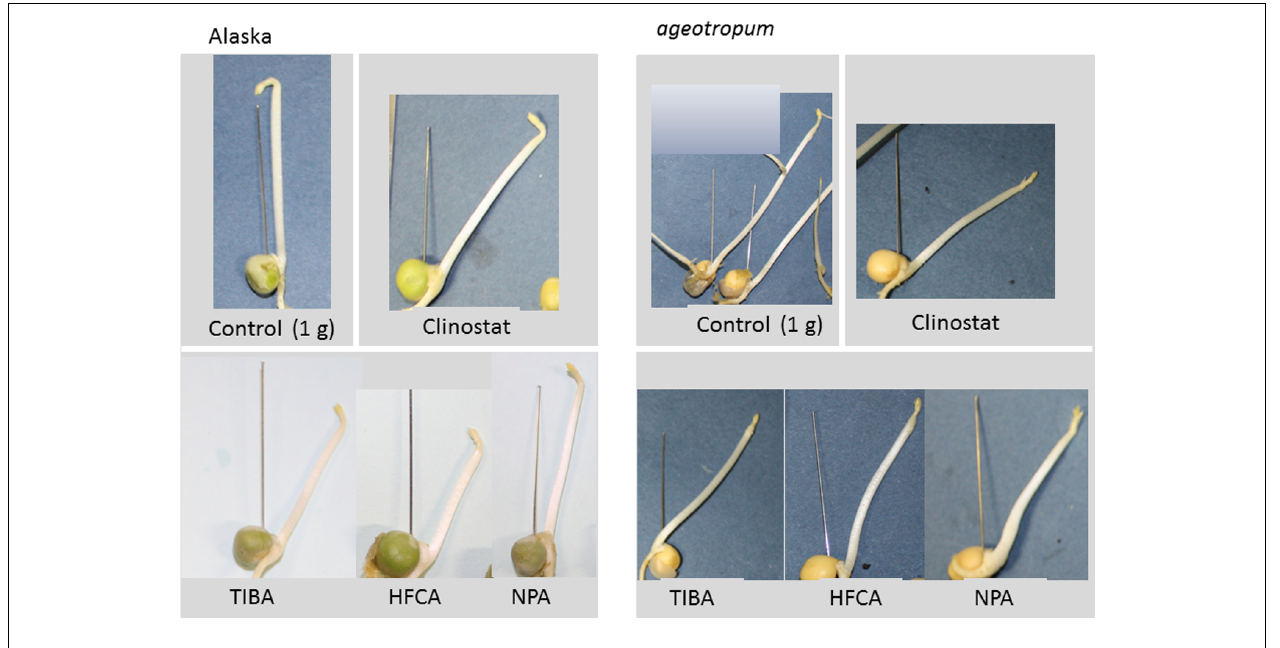
FIGURE 7 | Effects of auxin polar transport inhibitors on the hook development and the epicotyl bending in Alaska and ageotropum . Aqueous solutions (10 μ M) of inhibitors were individually added to the rock wool blocks embedding dry seeds, and seedlings were grown under 1- g